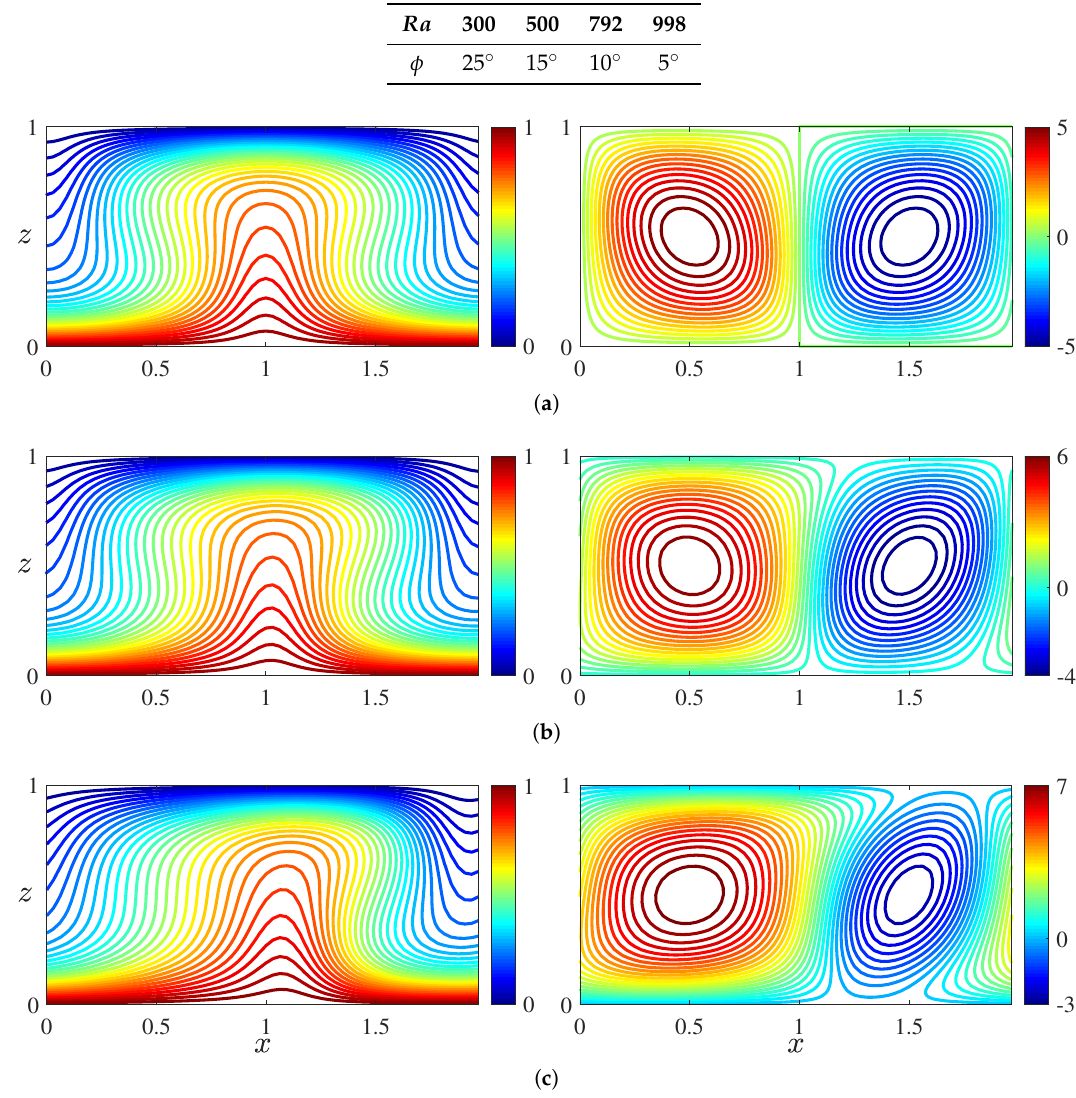
Table 1. Approximate angle φ at which the flow transitions from two-cell convection to four-cell convection in numerical simulations at moderate Ra and L = 2.